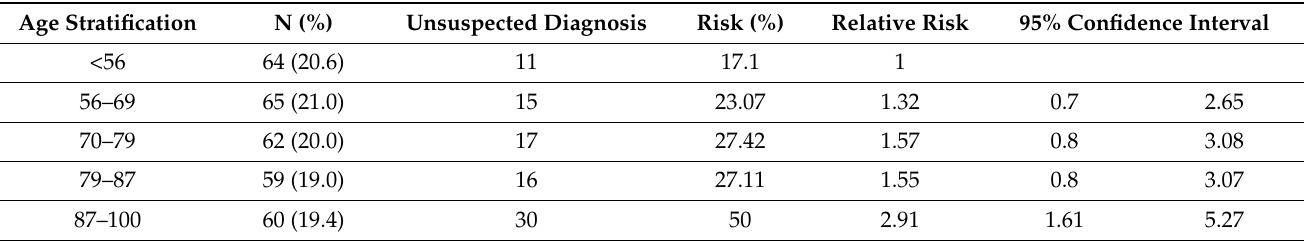
Table 4. Risk of relevant unsuspected diagnosis by multi-organ point-of-care ultrasound stratified by age (N =